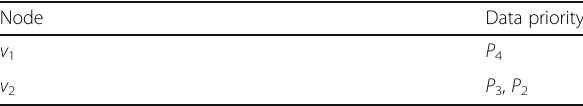
Fig. 2. Research motivation